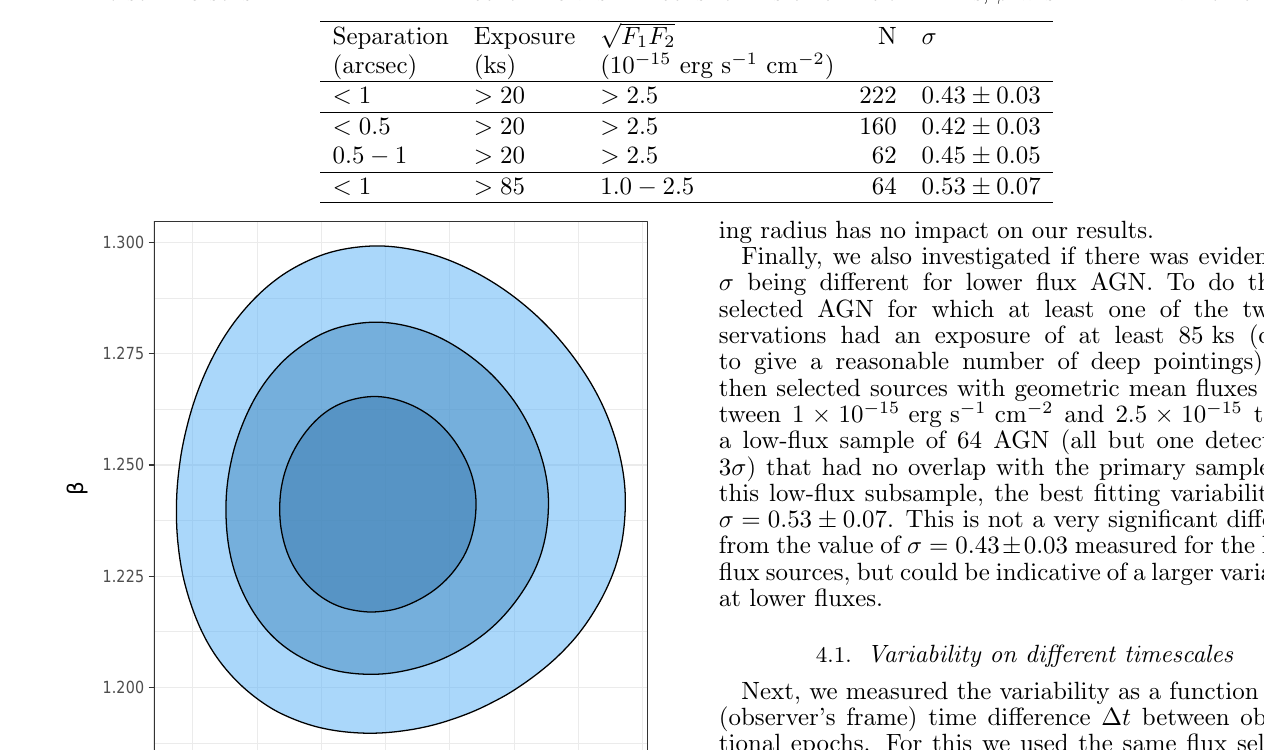
TABLE 3 AGN variability for different subsets of AGN. In all cases, the minimum interval between observations was one year. The first column the allowed range in separation between the sources in the two observations. The second column is the threshold in exposure time that must be exceeded by at least one of the observations. The third column gives the allowed range of the geometric mean flux of the two observations. The fourth column gives the number of AGN in the resulting subsample and the final column gives the constraints on σ . For all fits, β was fixed at a value of 1.24.